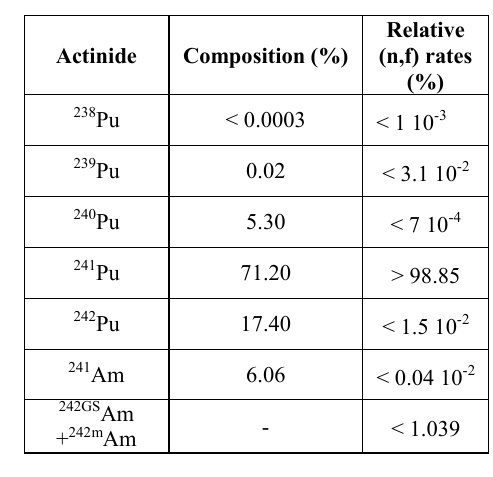
Table 1. Initial target composition and limits on fission rates after 6 day irradiation for the July 2016 experiment with the LOHENGRIN